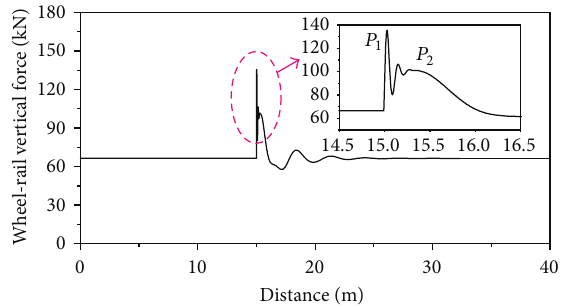
Figure 9: Rail support force in time domain.